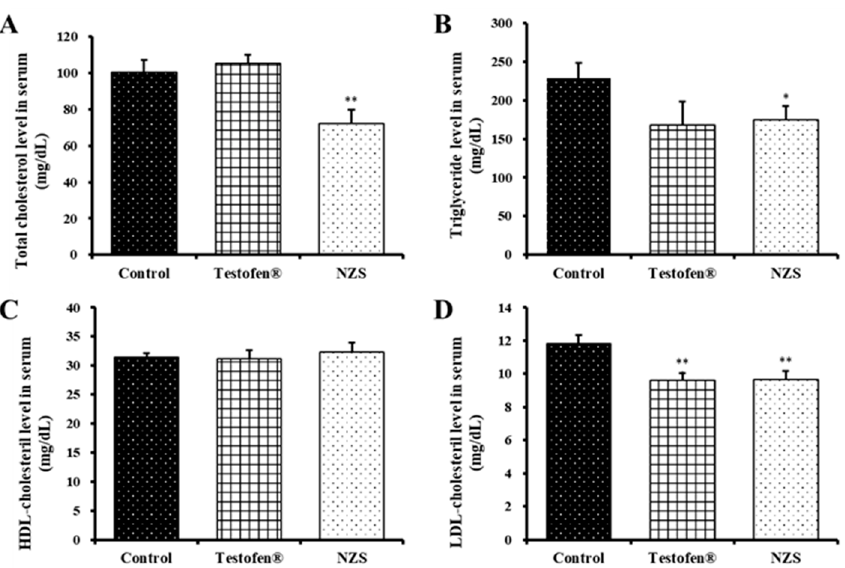
Figure 2. Comparative analysis of the serum levels of total cholesterol ( A ), triglyceride ( B ), high- density lipoprotein (HDL) ( C ), and low-density lipoprotein (LDL) ( D ) after New Zealand spinach (NZS) extract administration for four weeks. Data are expressed as means ± standard error (n = 5). Symbols of * and ** denote significant differences compared to aged rat (control) at p < 0.05 and p < 0.01 levels, respectively.